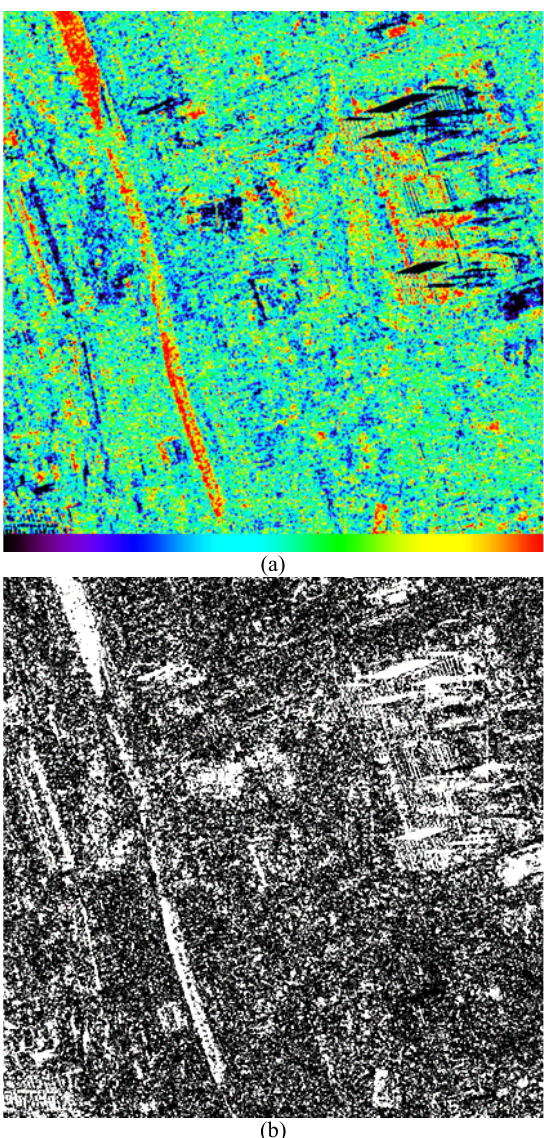
Figure 6. Despeckle example. (a) Ratio image (potential changes towards black and red). (b) Detected changes (white).